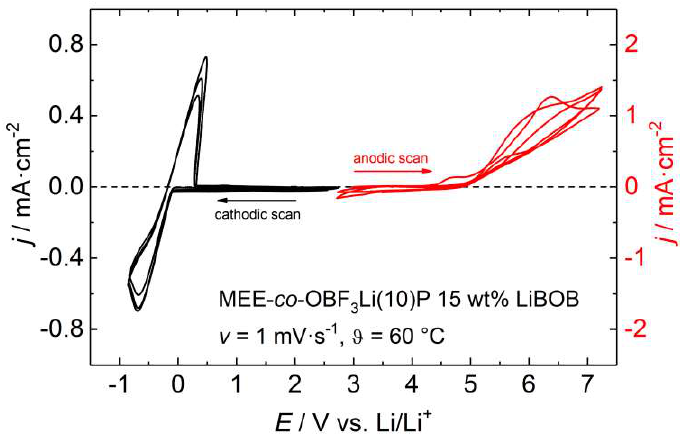
Figure 7 . Cyclic voltammogram of MEE- co -OBF 3 Li(10)P with 15 wt % LiBOB at 60 °C. Working electrode: Cu (for the cathodic scan on the left) and Pt (for the anodic scan on the right).